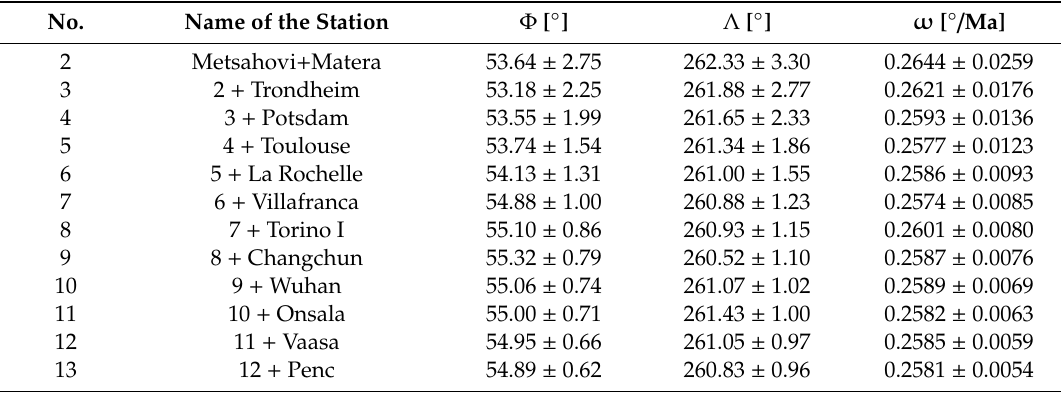
Table A2. Computed plate motion parameters, and their errors, of the Eurasian plate for the GNSS network using the sequential method. Scenario 2 of the